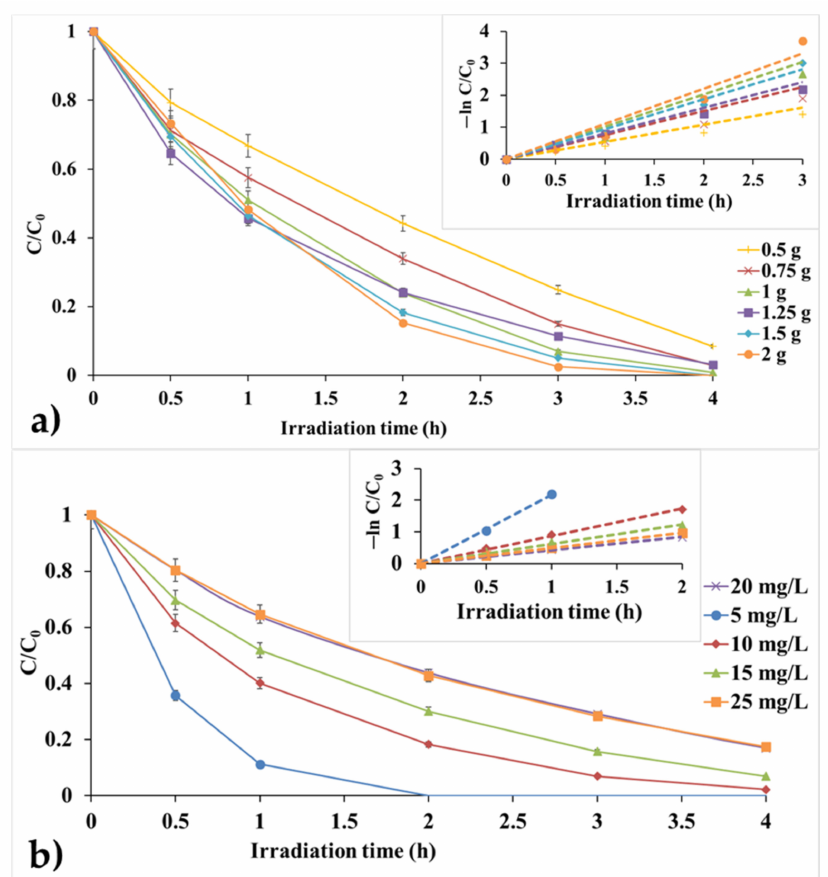
Figure 10. Effects of ( a ) catalyst dosage, and ( b ) initial caffeine concentration and their corresponding apparent degradation rate constant (insets) at initial pH =